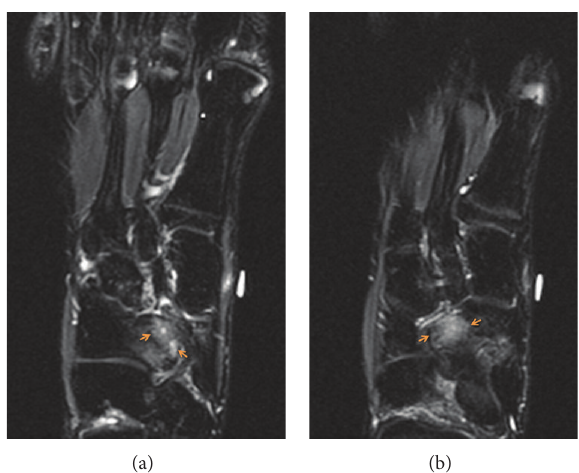
Figure 3: (a)-(b) Coronal short tau inversion recovery (STIR) unenhanced MR images of the right foot in a 17-year-old male with cuboid- navicular coalition demonstrate marrow edema and cystic change in the cuboid (arrows, (a)) as well as bone marrow edema in the navicular (arrows, (b)).